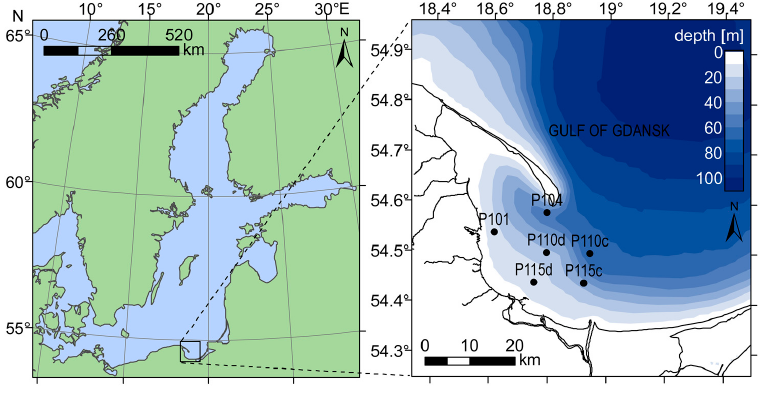
Figure 1. Location of the sample stations in the Gulf of Gdansk, Baltic Sea.